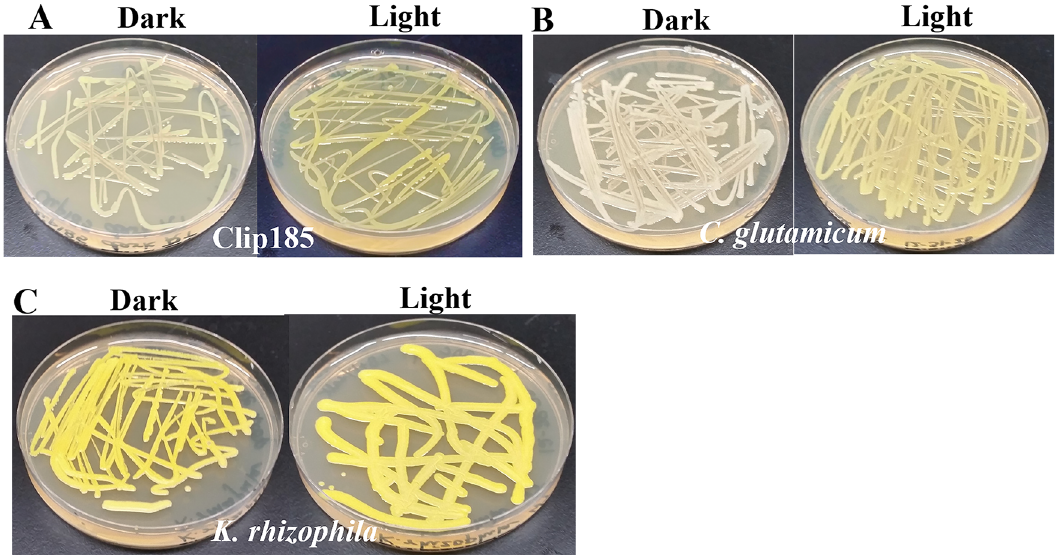
Figure13.DecaprenoxanthinproductionunderlightanddarkonLBmedia. (A)Decaprenoxanthinproductionin Clip185 under darkness and light. (B) Decaprenoxanthin production in C. glutamicum under darkness and light. (C) Decaprenoxanthin production in K. rhizophila under darkness and light. Bacterial culture plates were exposed to darkness or light for 5 days at 22 ° C and then imaged. Light intensity was 20-25 μ mol m -2 s -1 .